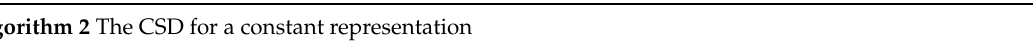
Algorithm 2 The CSD for a constant representation